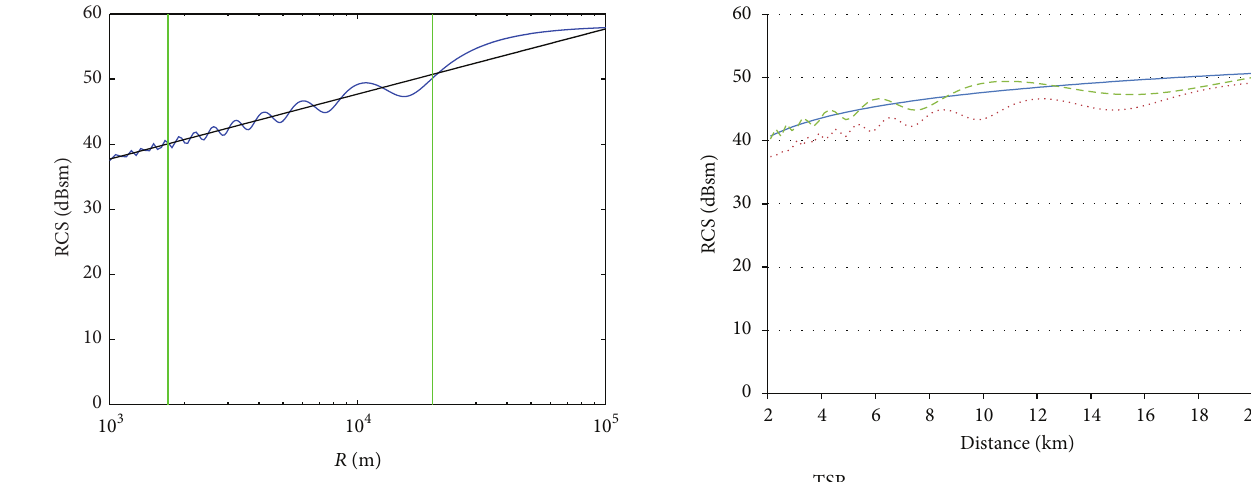
Figure 10: RCS values of a tapered cylinder, as a function of the distance to the radar. Comparison of the proposed method (black line) and Welsh’s theoretical expression (blue line) [39]. Green lines delimit usual distances for offshore wind farms from the coastline [35].